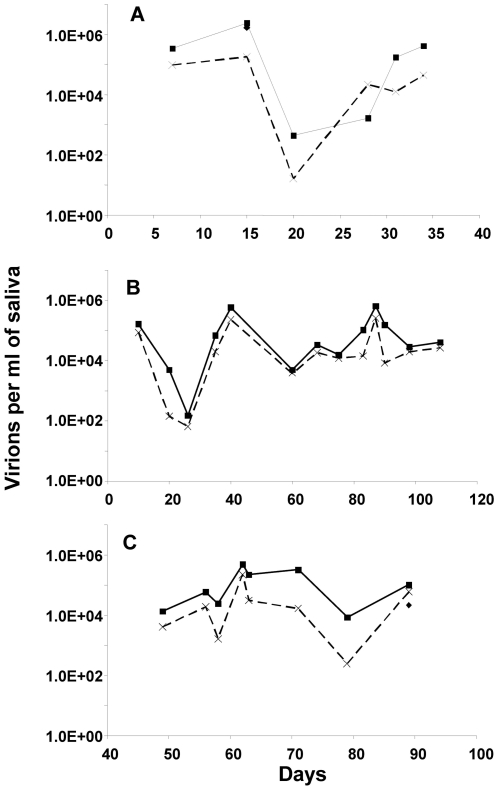
The variation in virus shedding into saliva over time is consistently seen in clarified and DNase treated preparations.Solid line = Saliva was pretreated with DNase to remove unencapsidated viral DNA. Broken line = Saliva was clarified by centrifugation and then treated with DNase. Data is shown for three different subjects (A–C).